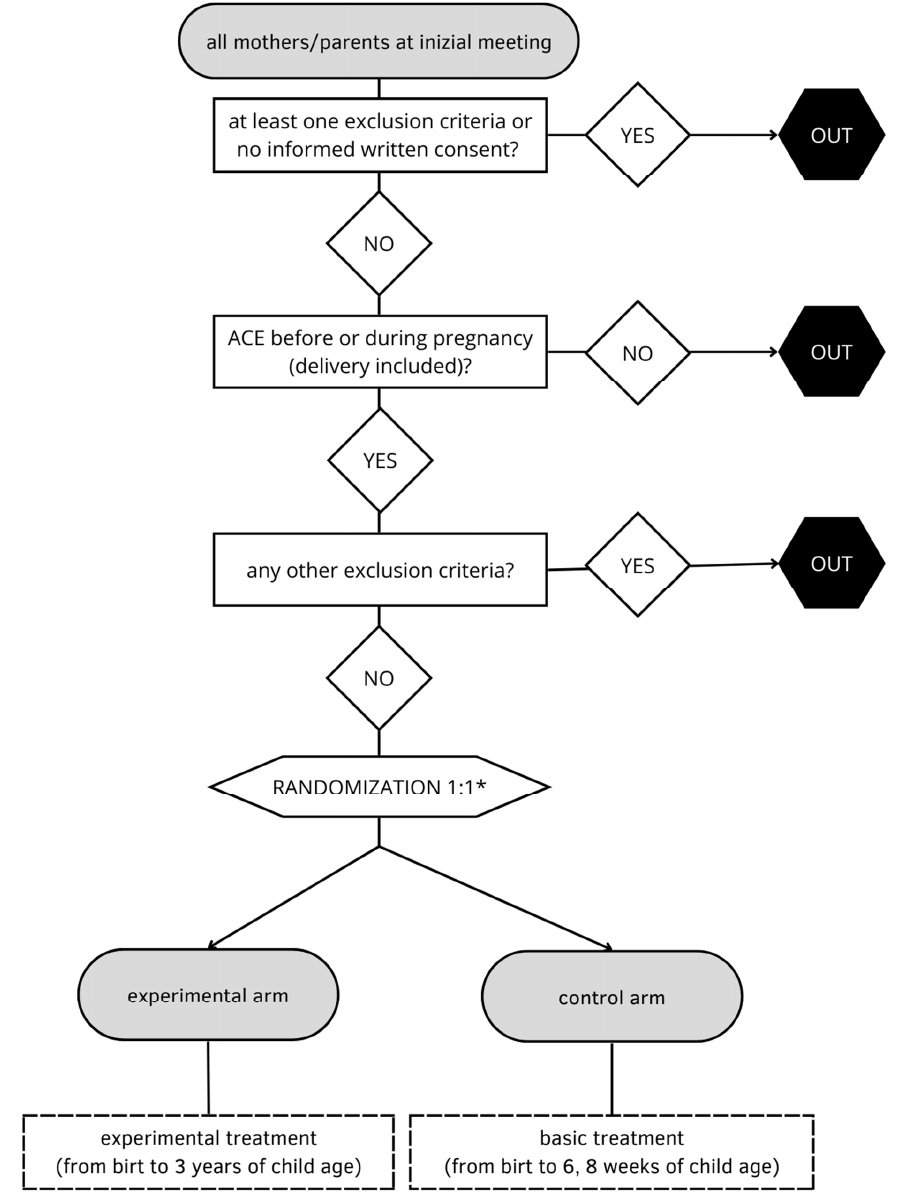
Figure 1. Study design. * Randomization will take place, as soon the ACEs will be detected.